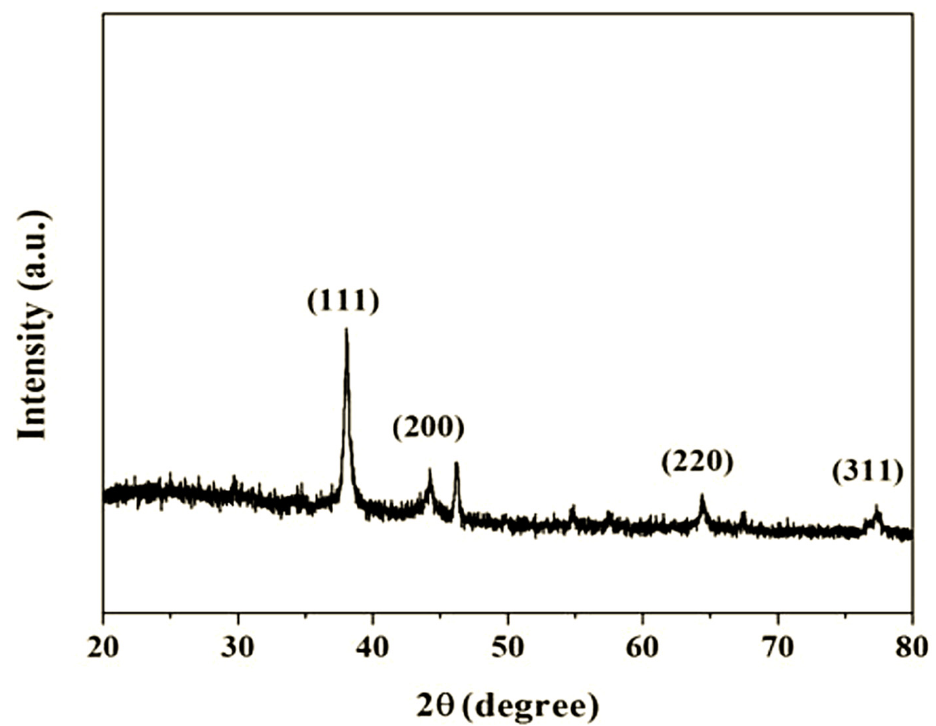
Figure 4. XRD pattern of AC-AgNPs.